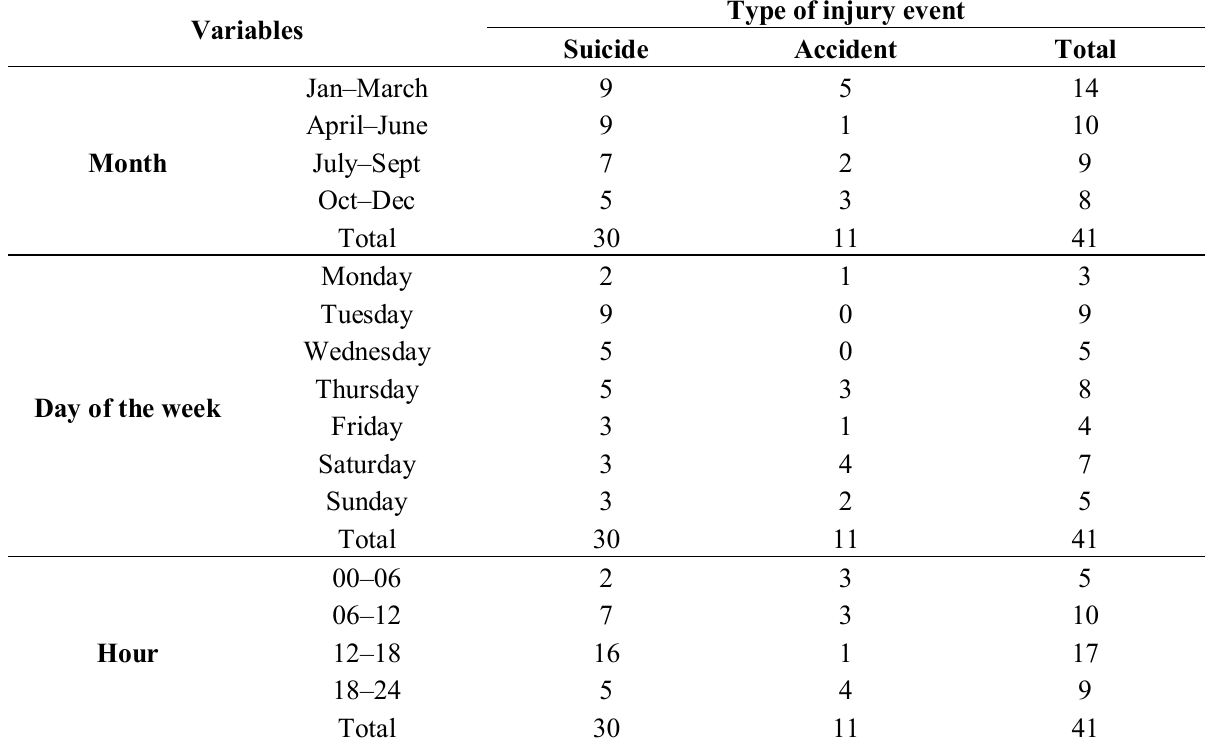
Table 2. Fatal train-person collisions by time of occurrence (month, day and hour) and type of injury on railway property in the greater Stockholm area